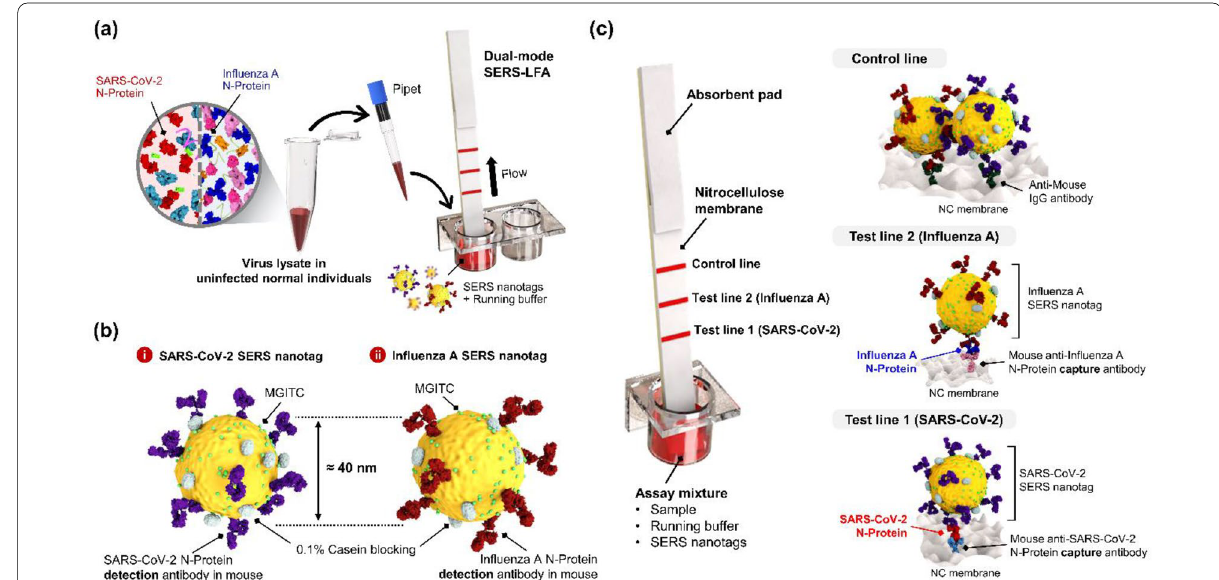
Fig. 2 Working principle of the dual-mode SERS-LFA strip for simultaneous detection of SARS-CoV-2 and influenza A virus. a Preparation of virus lysates in a nasopharyngeal solution of normal individuals. This virus solution was mixed with SERS nanotags and a running buffer solution in a 96-well plate. b N-protein antibody-conjugated SERS nanotags for the detection of SARS-CoV-2 and influenza A virus. c SERS nanotags and running buffer move toward the SERS-LFA strip by capillary force. Formation of sandwich immunocomplexes for SARS-CoV-2 (test line 1) and influenza A virus (test line